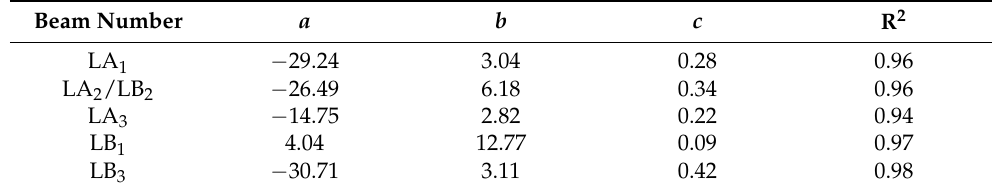
Table 5. Result of fitting